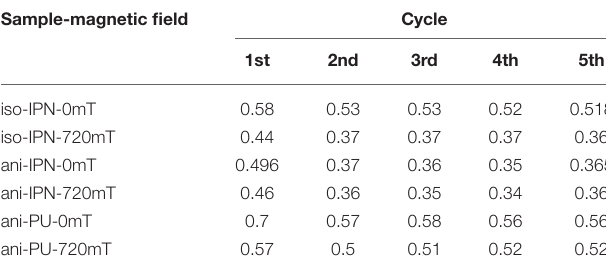
TABLE 2 | G ′ 0 (MPa) of the samples in the different cycles. Sample-magnetic field